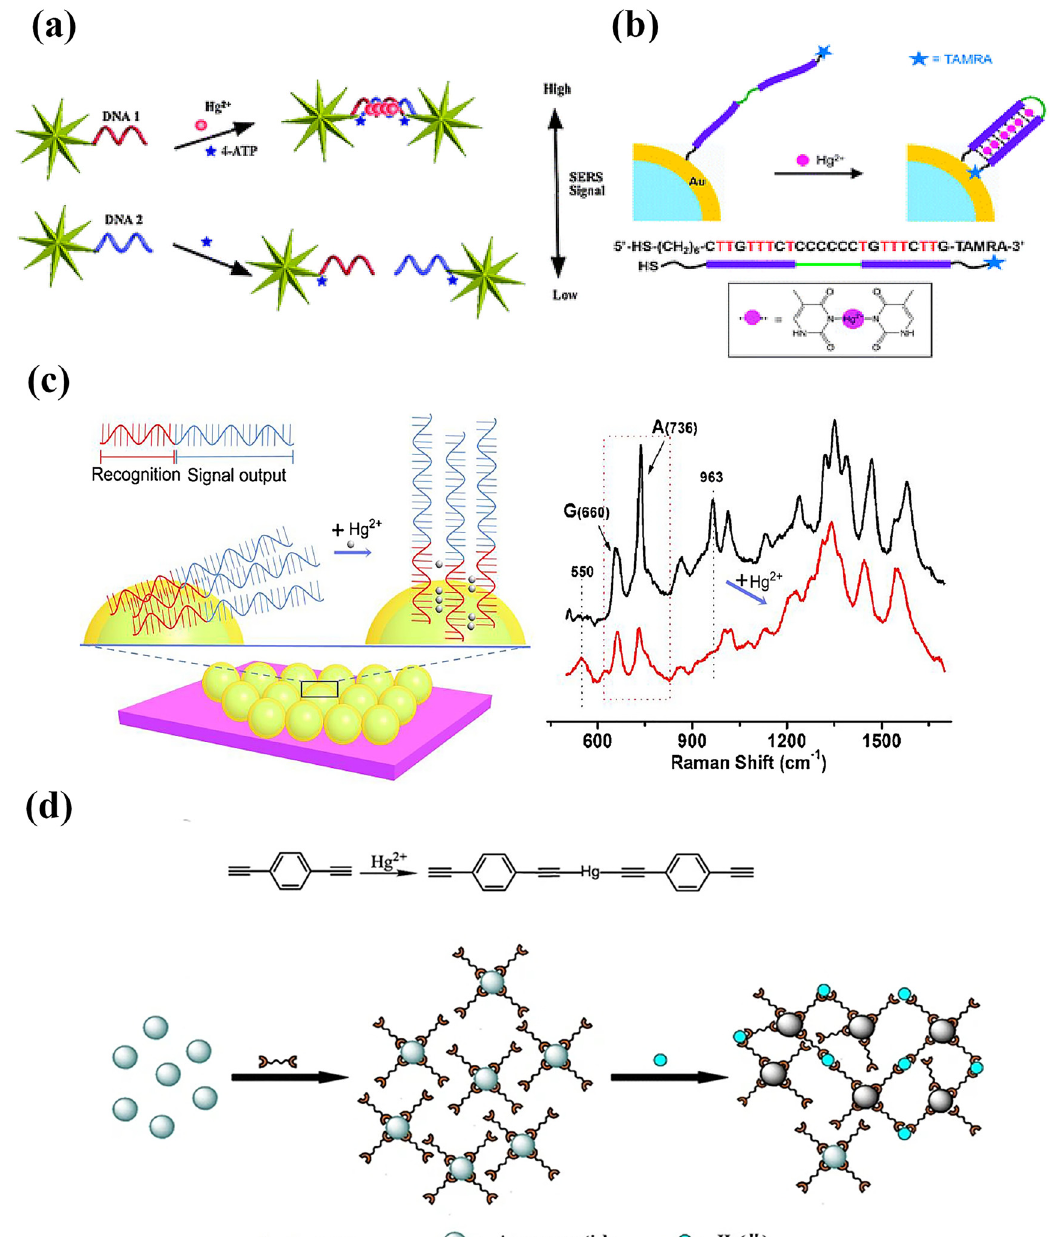
Figure 2: Schematic diagram of the detection of Hg 2 + ions based on “ turn-on ” mode. (a) Self-assembly gold nanostars aggregated to dimers based on the T – Hg 2 + – T structure [57]. (b) The DNA aptamer was induced into a hairpin structure[60].(c)TheDNAaptameradsorbedverticallyonthesurfaceofSiO 2 @Aucore/shellnanoparticles[61].(d)Hg 2 + ionsconnectedtoDEB to trigger the aggregation of AgNPs